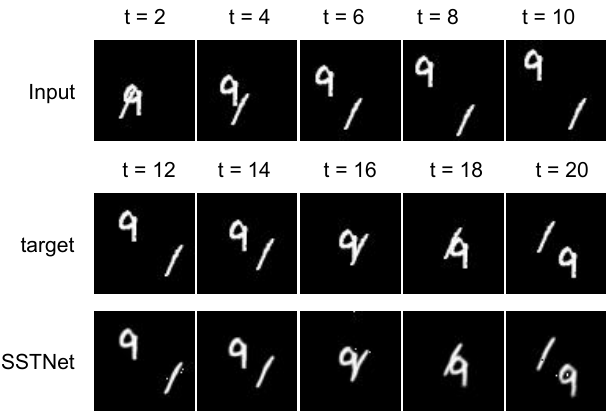
Figure 5. Visualization of the MovingMNIST dataset.